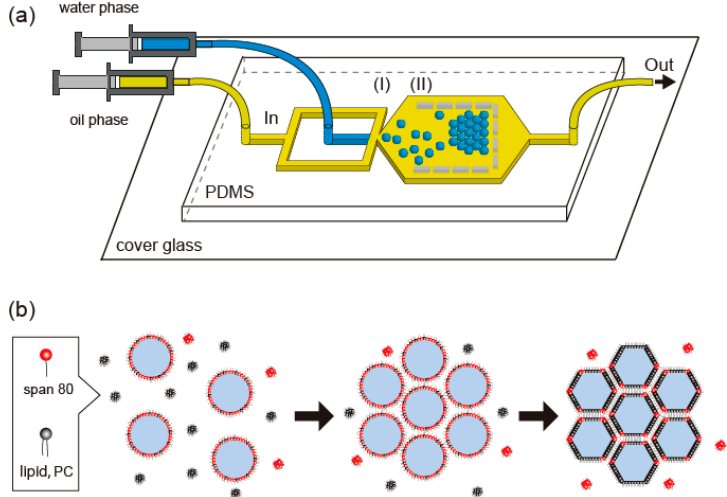
Figure 1. Schematic of ( a ) a microfluidic device for preparing the close-packed honeycomb pattern of assembled droplets in a two-dimensional space and of ( b ) droplet interface bilayer (DIB) formation among droplets. Span 80 molecules (red), having a higher adsorption rate than lipid 1,2-dioleoyl-sn-glycero-3-phosphocholine (PC,black), initially accumulate on droplet surface. Replacement of Span 80 with PC initiates DIB formation and surface adhesion among